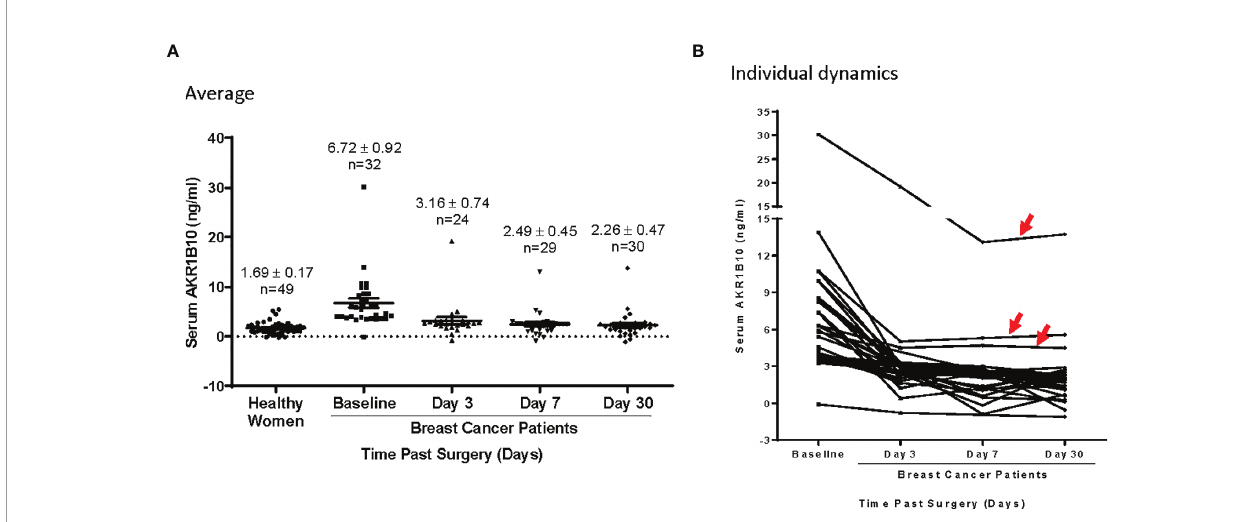
FIGURE 4 | (A) AKR1B10 level dynamics in patients undergoing lumpectomy or mastectomy. The AKR1B10 levels signi fi cantly dropped on day 3 and plateaued thereafter till day 30 to baseline similar to healthy controls. (B) In this collection, 3 cases (red arrows) showed dramatic drops of serum AKR1B10 post surgery but maintained a level that was higher than healthy control. This indicates that these case continued expression of AKR1B10 probably secondary to micro